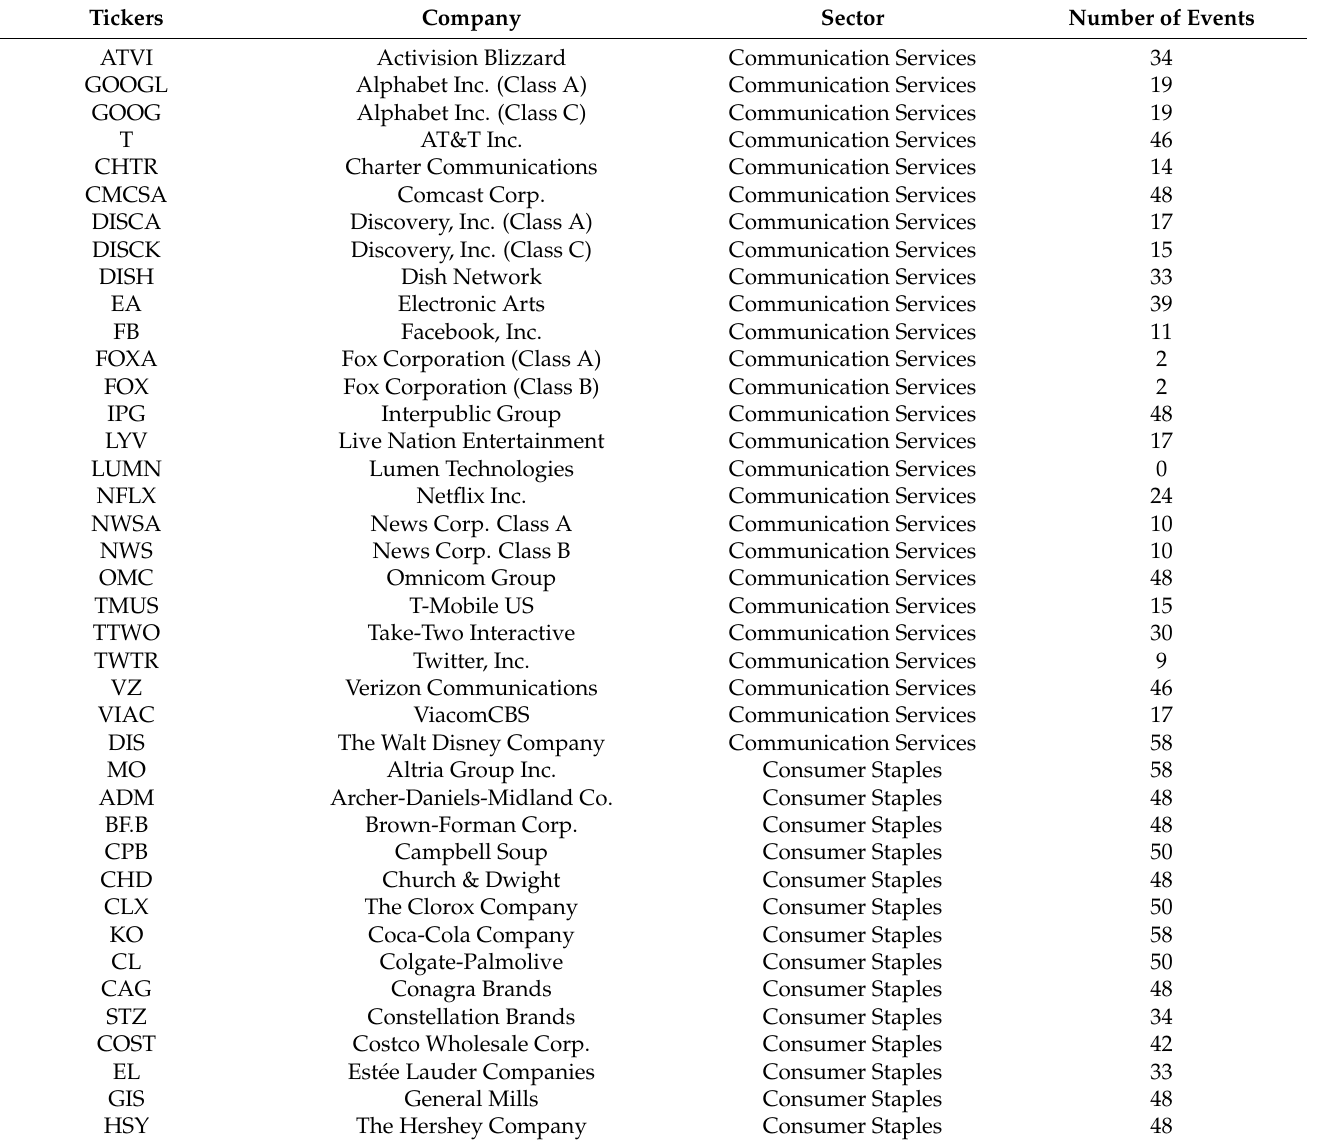
Table A4. Number of events per firm in the Information Technology, Communication Services, and Consumer Staples sectors included in the event